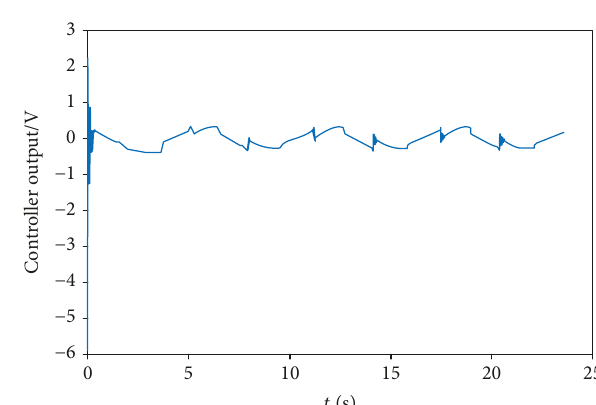
Figure 7: Controller output.